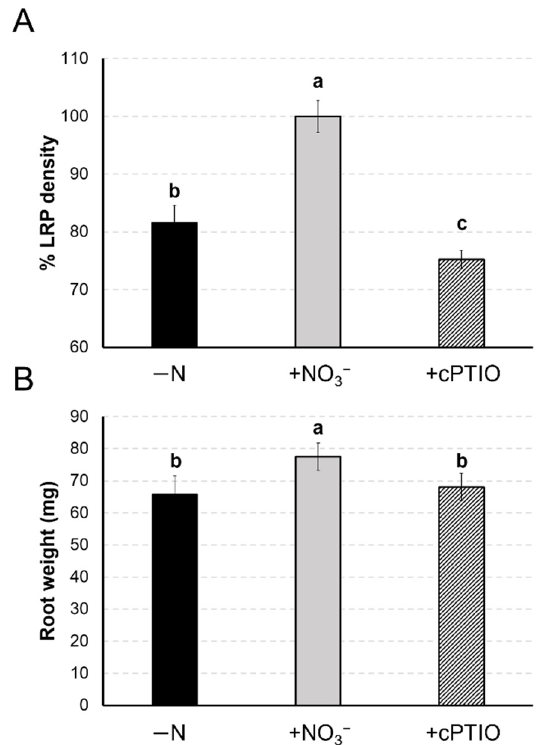
Figure 7. Lateral root density (LRP) and root weight of maize seedlings exposed to NO scavenger. Maize seedlings were grown in an N-depleted solution for 24 h and then transferred for 24 h in a nitrogen depleted solution ( − N), or 24 h in a 1 mM nitrate supplied solution (+NO 3 − ), or 24 h in a 1 mM NO 3 − supplied solution plus 1 mM NO scavenger cPTIO (cPTIO). Hematoxylin staining was used to detect lateral root primordia (LRP). ( A ) Data are expressed as increment of LRP density respect to the +NO 3 − treated roots. Roots of all maize seedlings were separated and individually weighed. ( B ) The average weight of roots was calculated for every biological repetition and then averaged between the three biological repetitions. Results are presented as mean ± SE from three biological replicates for each treatment and an ANOVA statistic test was performed ( n = 20). Letters above the bars indicate different significance groups ( p < 0.05).